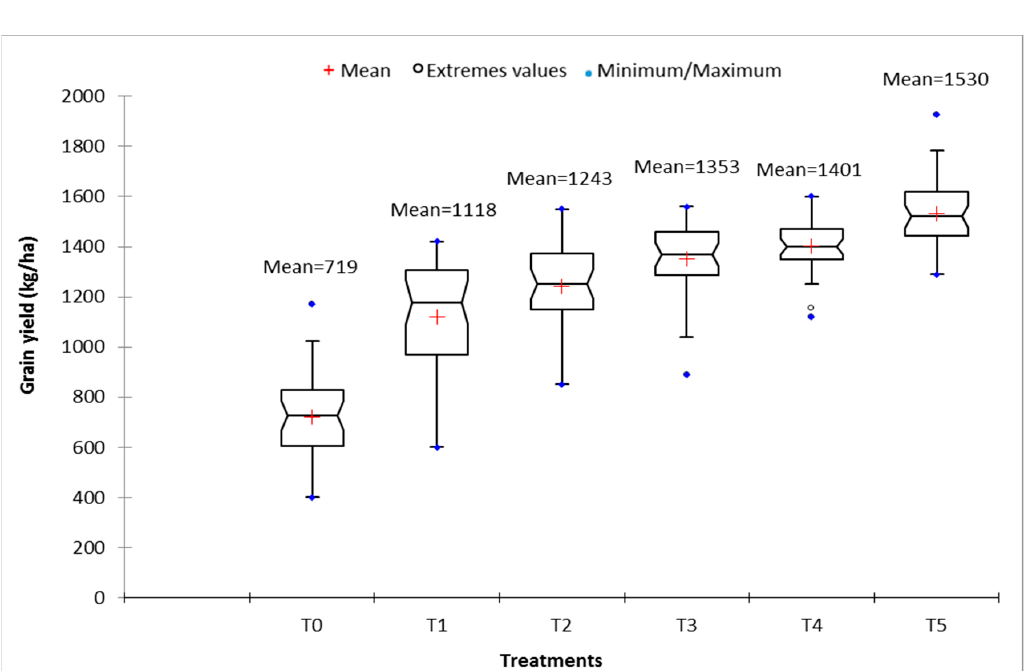
Figure 4. Effects of the treatments on pearl millet grain yield across three sites over two years in the on-station experiments. Averages of treatments and corresponding 95% confidence intervals are presented.